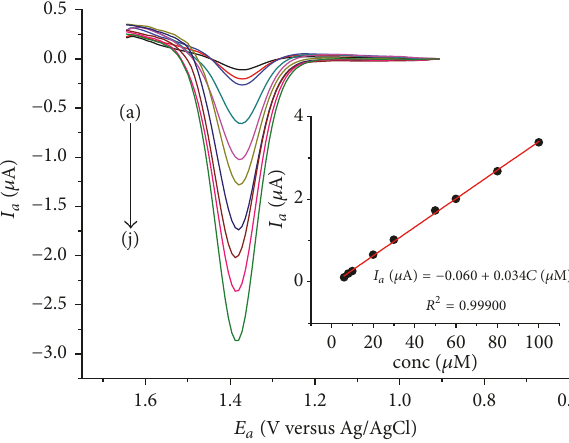
Figure 6: DPVs of LGCE in pH 4 ABS containing (a) no, (b) 1mM caffeine, and (c) 1 mM caffeine corrected for the blank under optimized conditions.